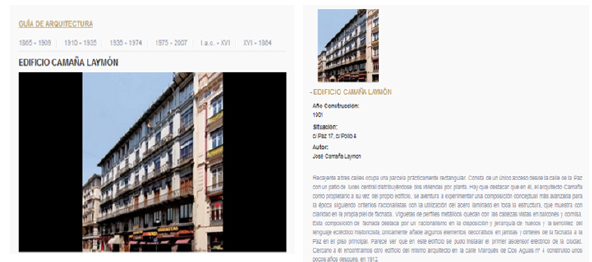
Figure 13. Building Camaña Laymon at La Paz Street.